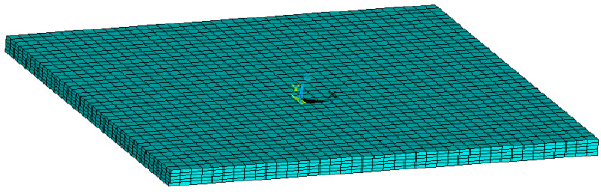
Figure 4. Initial FE model for the simple shear test.